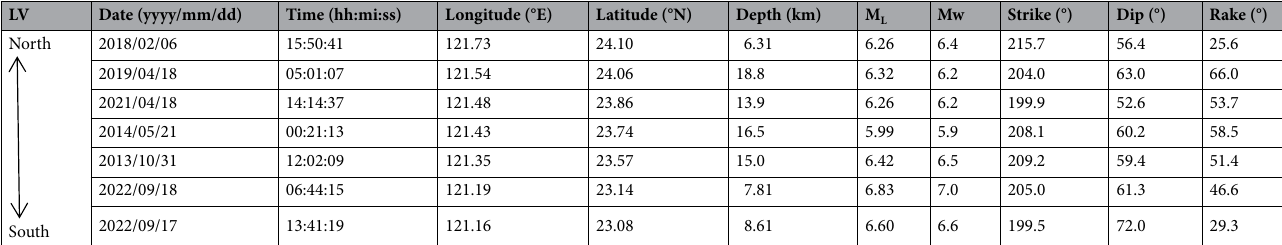
Table 1. List of large earthquakes that occurred along the LV suture in eastern Taiwan from 2013 to 2022. The event time, location, and local magnitude are provided by the CWB earthquake catalog 37 . The moment magnitude and focal mechanism are taken from the RMT CMT report 8